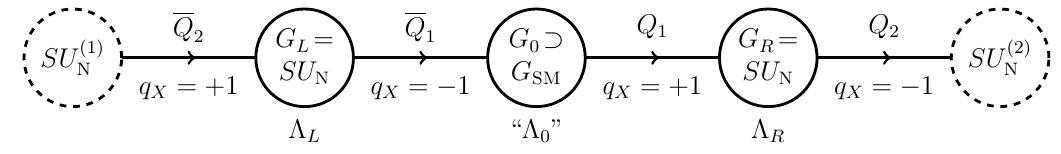
Figure 1 . Moose diagram indicating the charges of bifundamental matter (cid:12)elds Q under the gauge group SU( N ) L global symmetries. The Standard Model SU(3) c